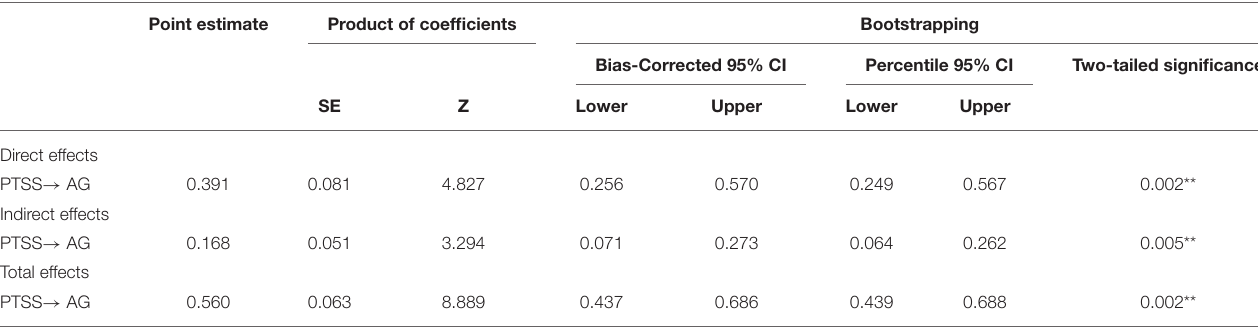
TABLE 4 | Direct, indirect, and total effects of the hypothesized